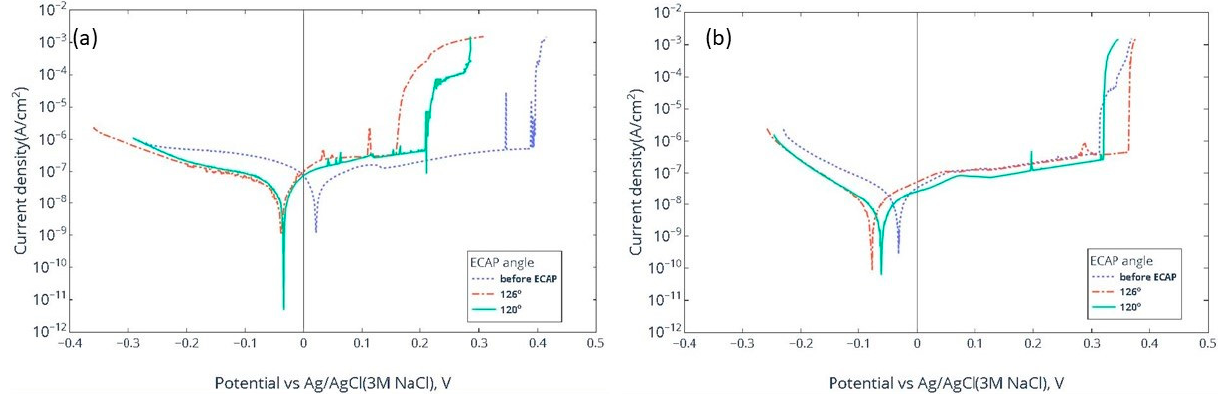
Figure 4. Metallographic observation of SS316L ( a ) before ECAP, ( b ) 120° ECAP and ( c ) 126° ECAP.